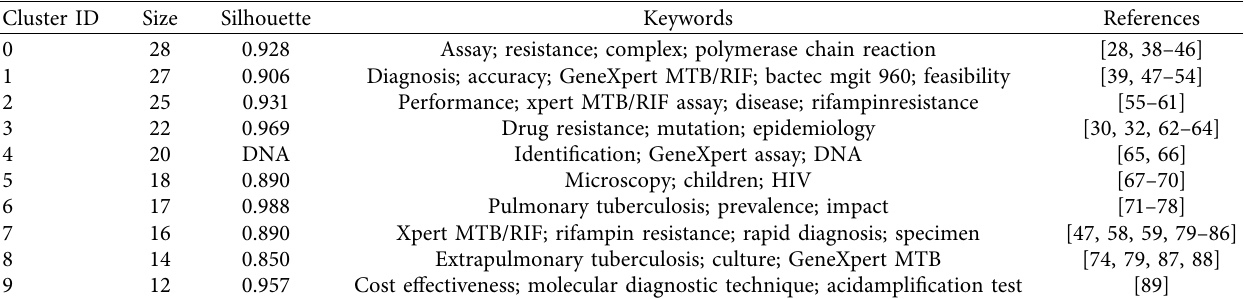
Table 5: Knowledge clusters in the field of GeneXpert in tuberculosis on keyword co-occurrences for each cluster.